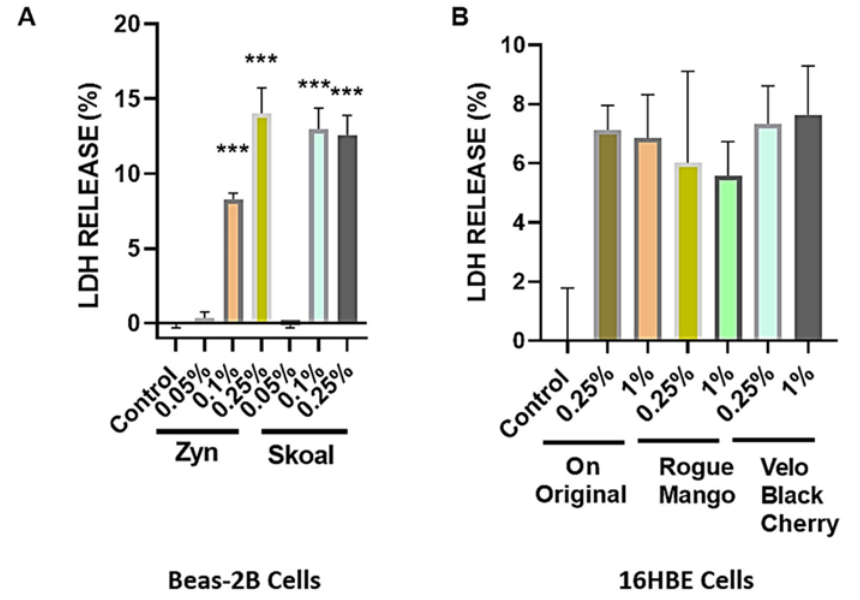
Figure 4. Differential cytotoxicity due to exposure of flavored oral smokeless nicotine products in bronchial epithelial cells. ( A ) BEAS-2B cells were seeded and treated with spearmint-flavored oral product extracts from two different brands. Following 24 h exposure, conditioned media was used for the lactate dehydrogenase (LDH) measurements. ( B ) 16HBE cells were seeded and treated with ON! Original, Rogue mango, or Velo black cherry-flavored nicotine pouch extracts. Following 24 h exposure, conditioned media was used LDH measurements. Data represented as means *** p < 0.001 compared to control. (Mean ± SEM, n = 3.)